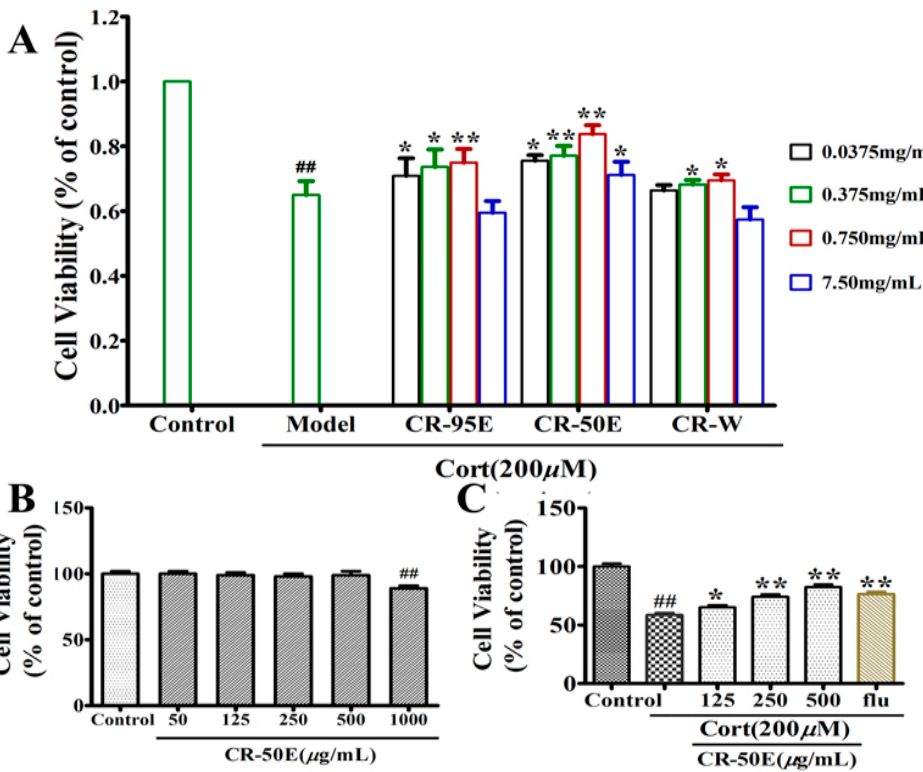
Figure 1. ( A ): The cell viability of different extract fractions from CR on corticosterone-treated PC12 cell; ( B ): cell cytotoxic effect was measured by the MTT assay after being cultured with various doses of CR for 24 h; C : cell survival was determined by the MTT assay; results are presented as means ± SD ( n = 6). ** p < 0.01, compared with control group, ## p < 0.01, compared with corticosterone (Cort).